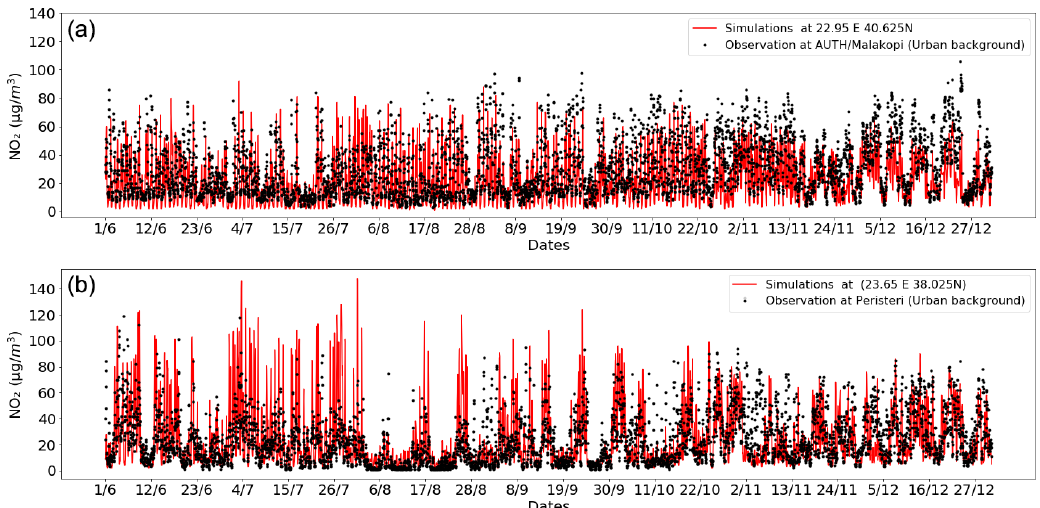
Figure 3. Time series of the hourly in situ measurements at two stations (black points) and the simulations of the model in the corresponding pixel (red lines) between June and December 2018. The urban background AUTH/Malakopi stations in Thessaloniki (a) and the urban background Peristeri station in Athens (b) are